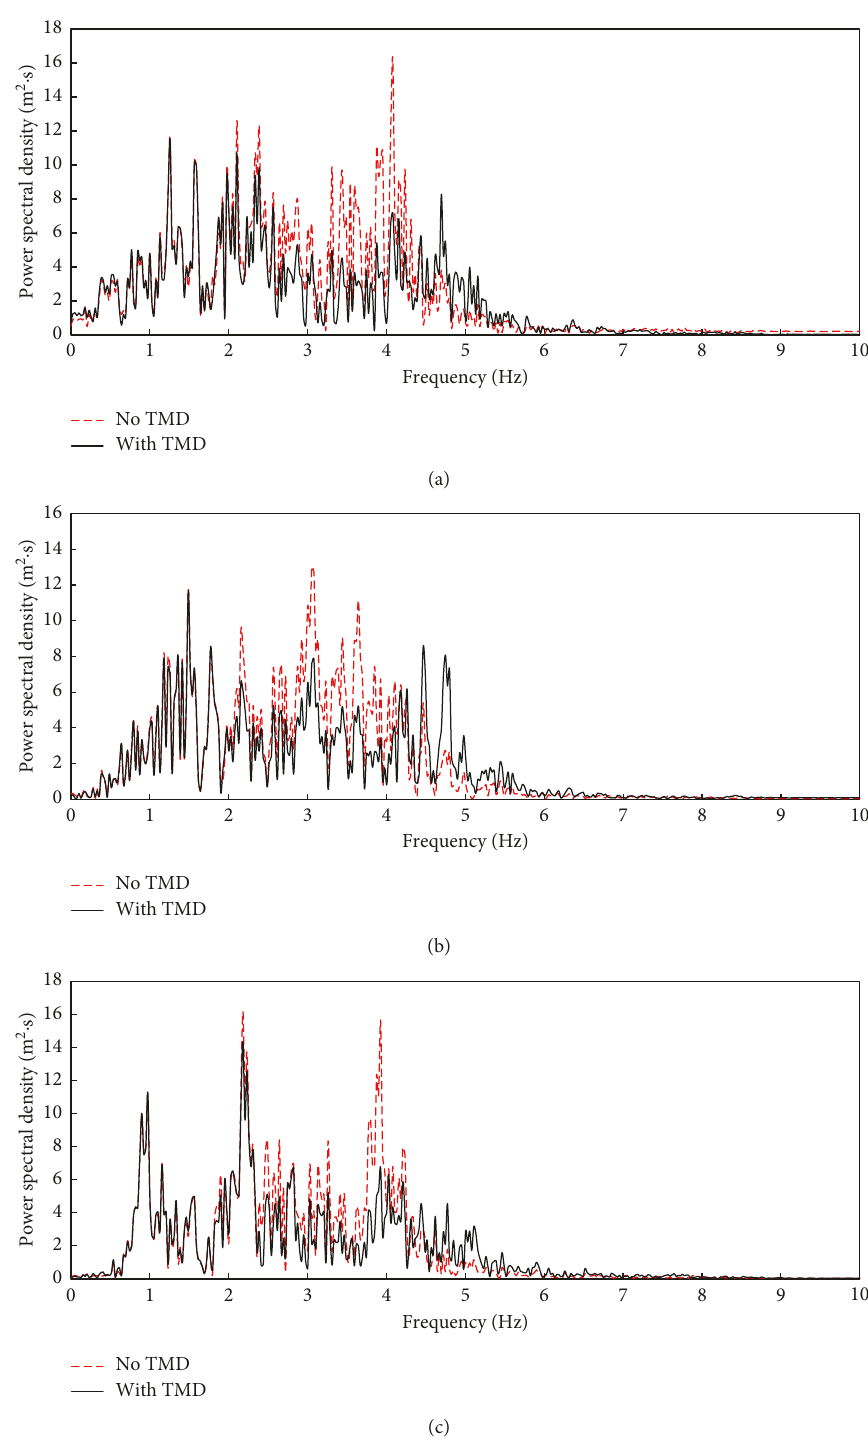
Figure 14: Power spectral density of the displacement under earthquake-induced seismic wave excitation. Power spectral density of the displacement for the (a) El-Centro NS earthquake seismic wave, (b) Taft EW earthquake seismic wave, and (c) Fukushima NS earthquake seismic